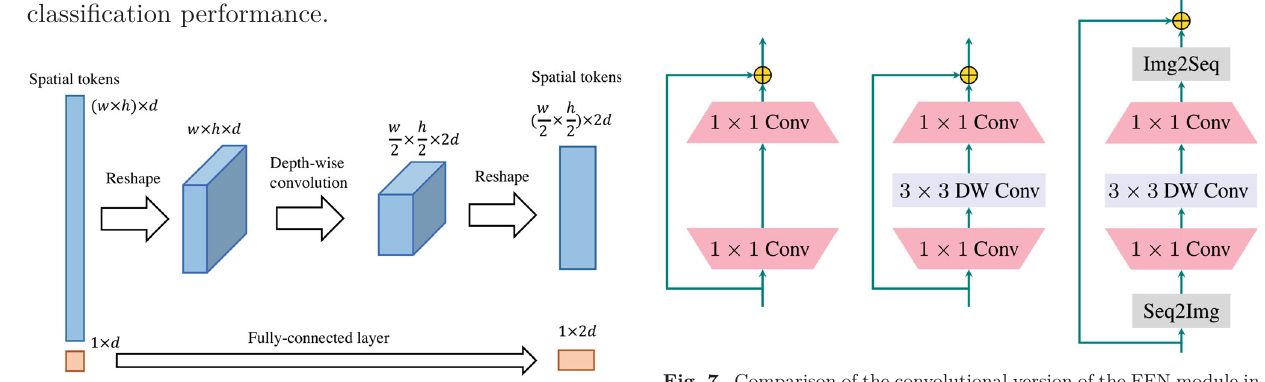
Fig. 7 Comparison of the convolutional version of the FFN module in ViT models (left), inverted residual blocks (center), and the proposed module in LocalViT to exploit the benefit of locality in ViT (right). Reproduced with permission from Ref. [22], c (cid:2) The Author(s)